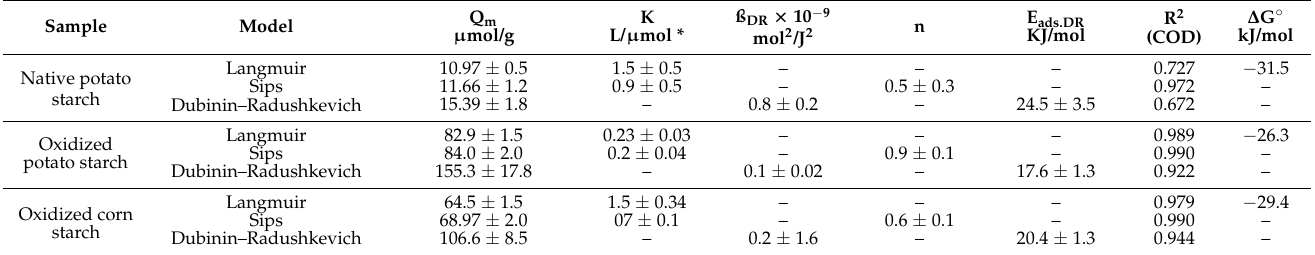
Table 4. Fitting parameters for the adsorption of Mn 2+ from MnSO 4 solution onto n. potato starch, o. potato starch and o. corn starch for Langmuir, Sips and Dubinin–Radushkevich isotherm